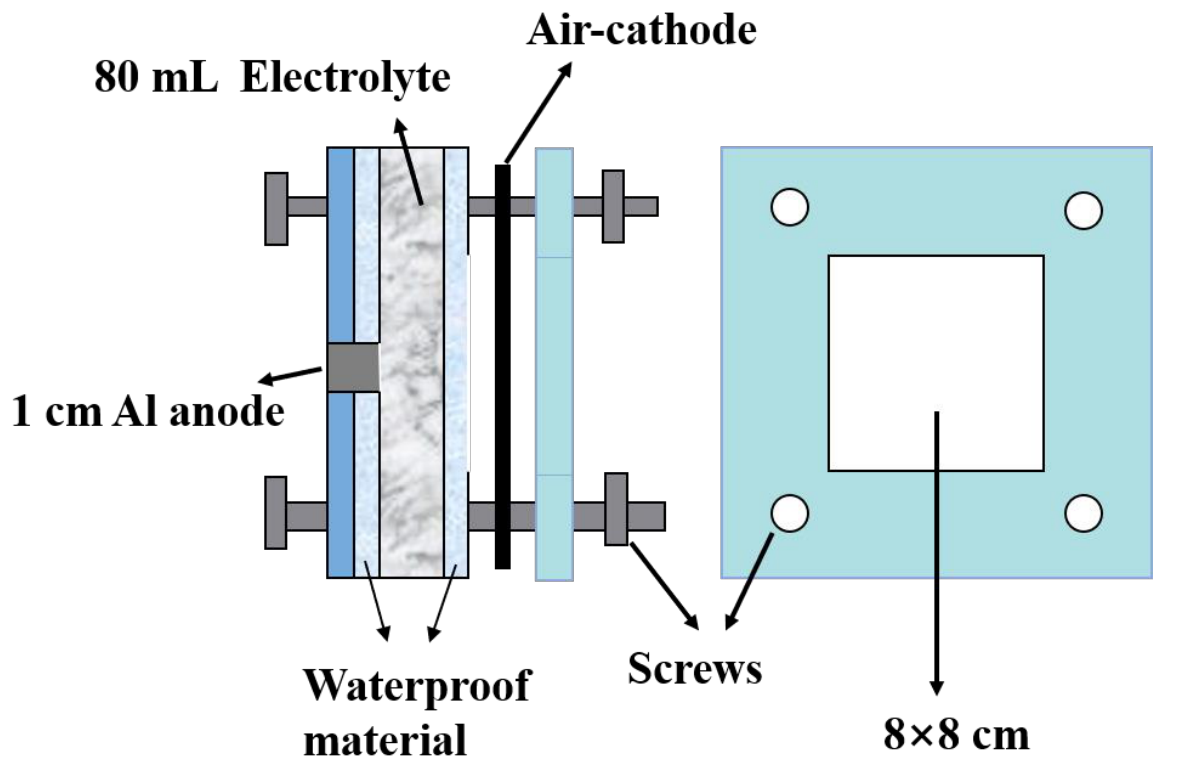
Figure 1. Schematic diagram of Al–air battery system. Table 1. Chemical composition of commercial purity Al.